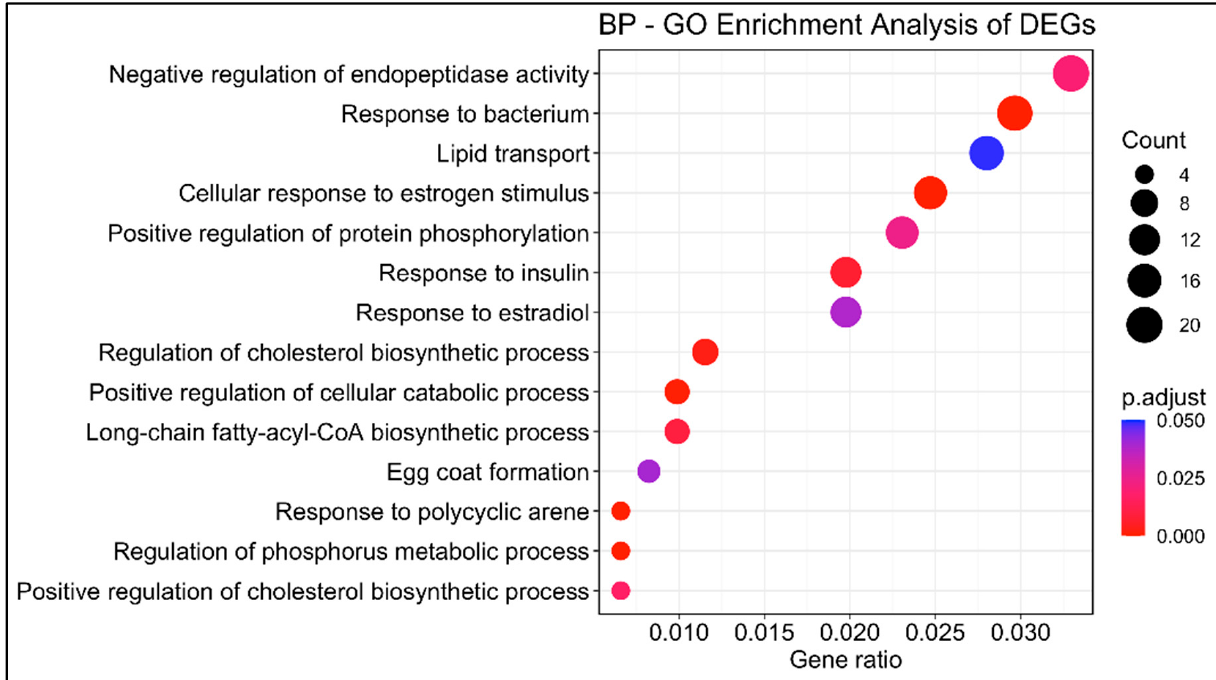
Figure 3. Gene ontology enrichment analysis of differentially expressed genes (DEGs) between livers of immature ( n = 3) and mature ( n = 3) females. y -axis indicates the GO term description; x -axis indicates the gene ratio. The size of the dot is based on gene count, and the color of the dot shows the GO term's enrichment significance ( p -adjust < 0.05).